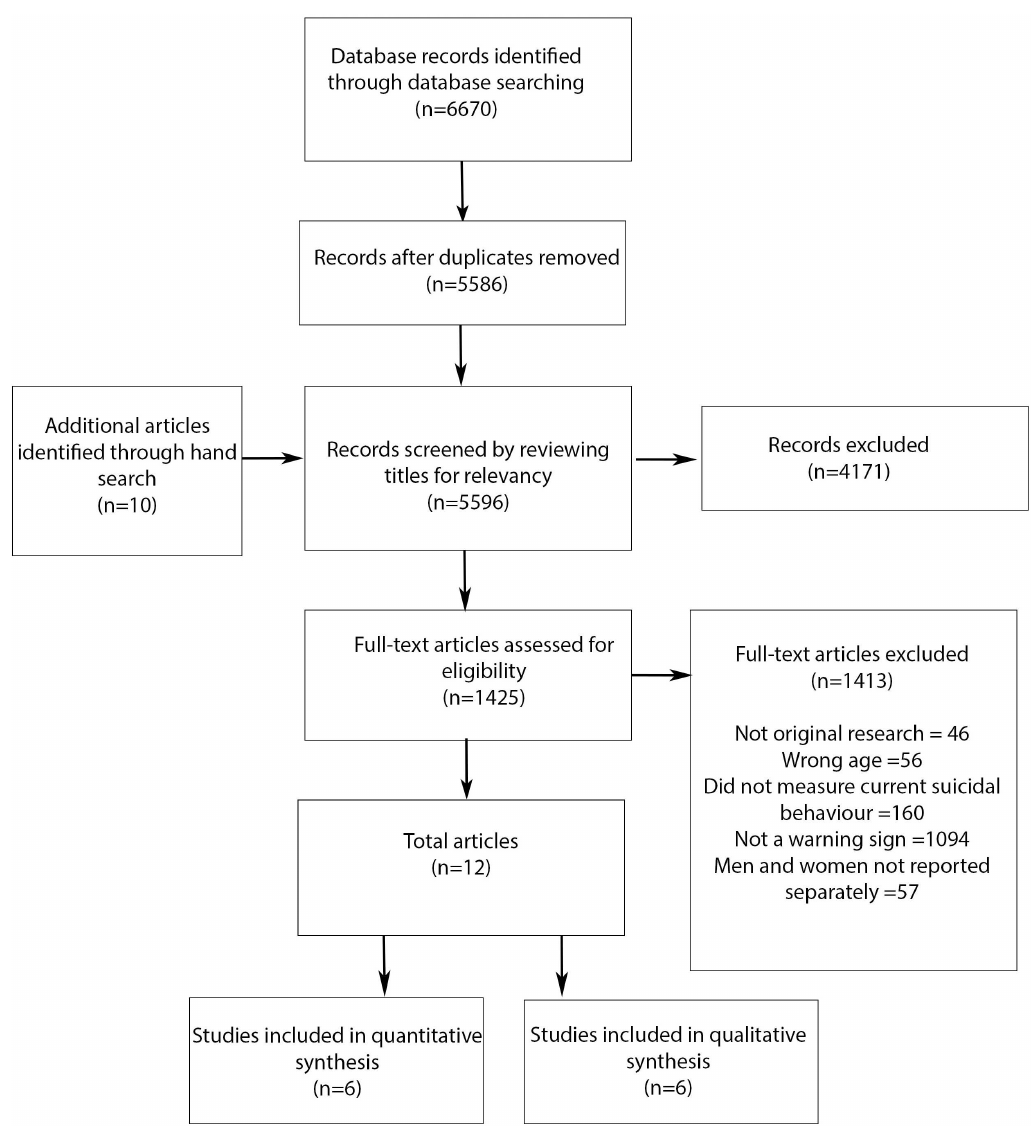
Fig 1. PRISMA-P flow chart of study